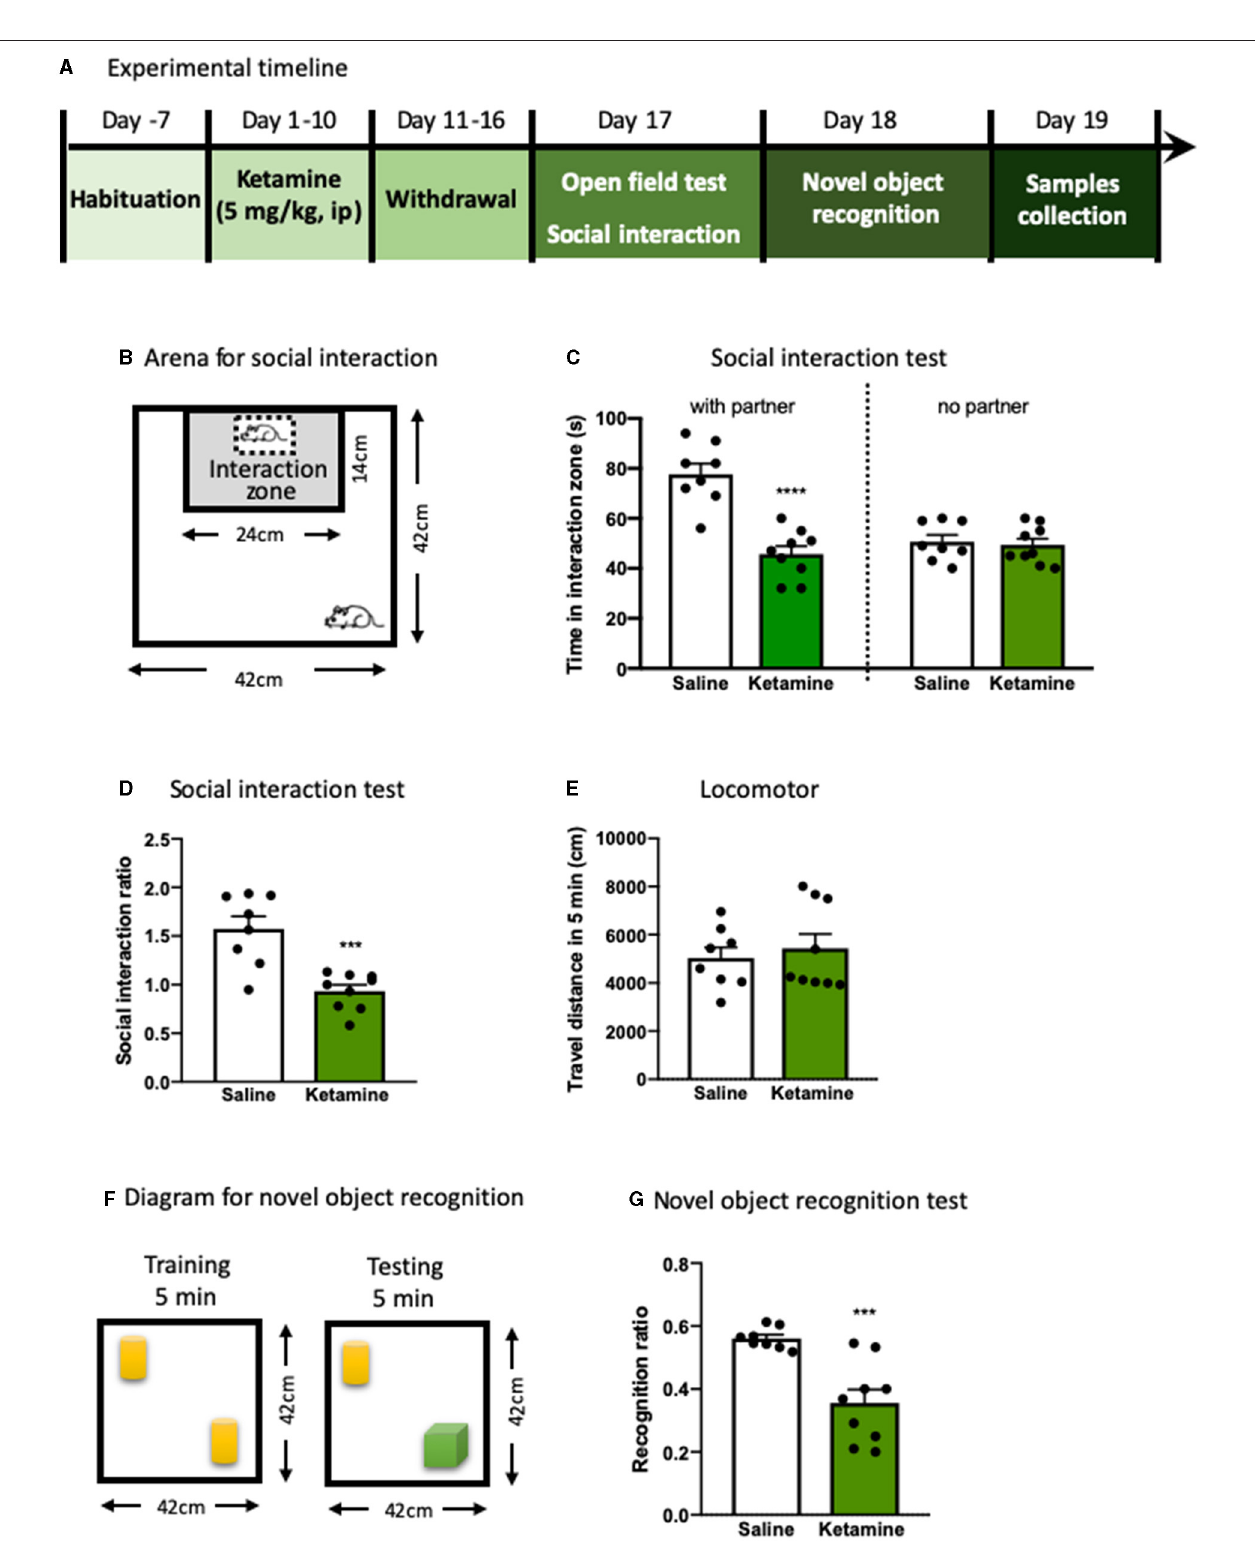
FIGURE 1 | The behavioral deficits induced by repeated ketamine administration. (A) Experimental timeline of ketamine treatment and behavioral protocol. (B) The graphical scheme of arena for social interaction test. (C) The time spent in the social interaction zone. (D) The social interaction ratio measured in social interaction test. (E) Total distance traveled during the 5- min open field test. (F) The diagram for novel object recognition test. (G) The recognition ratio measured in the novel object recognition test. Data are presented as mean ± SEM *** p < 0.001, **** p < 0.0001, compared with saline group. n = 8–9 per group.